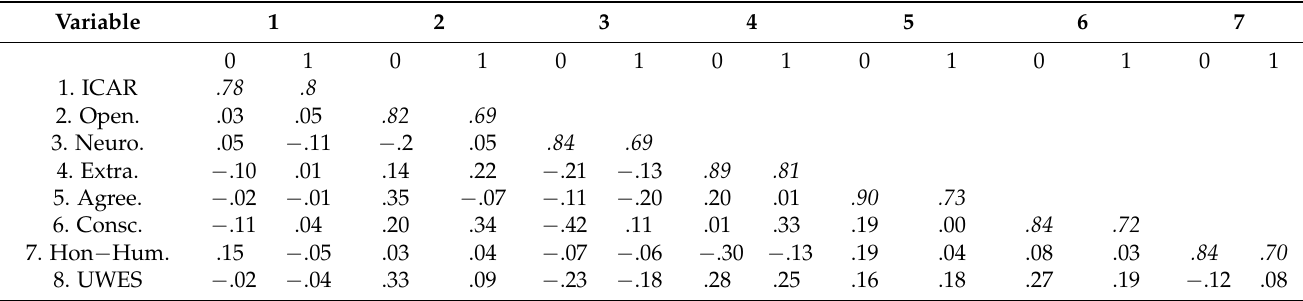
Table 2. Correlations between study variables.